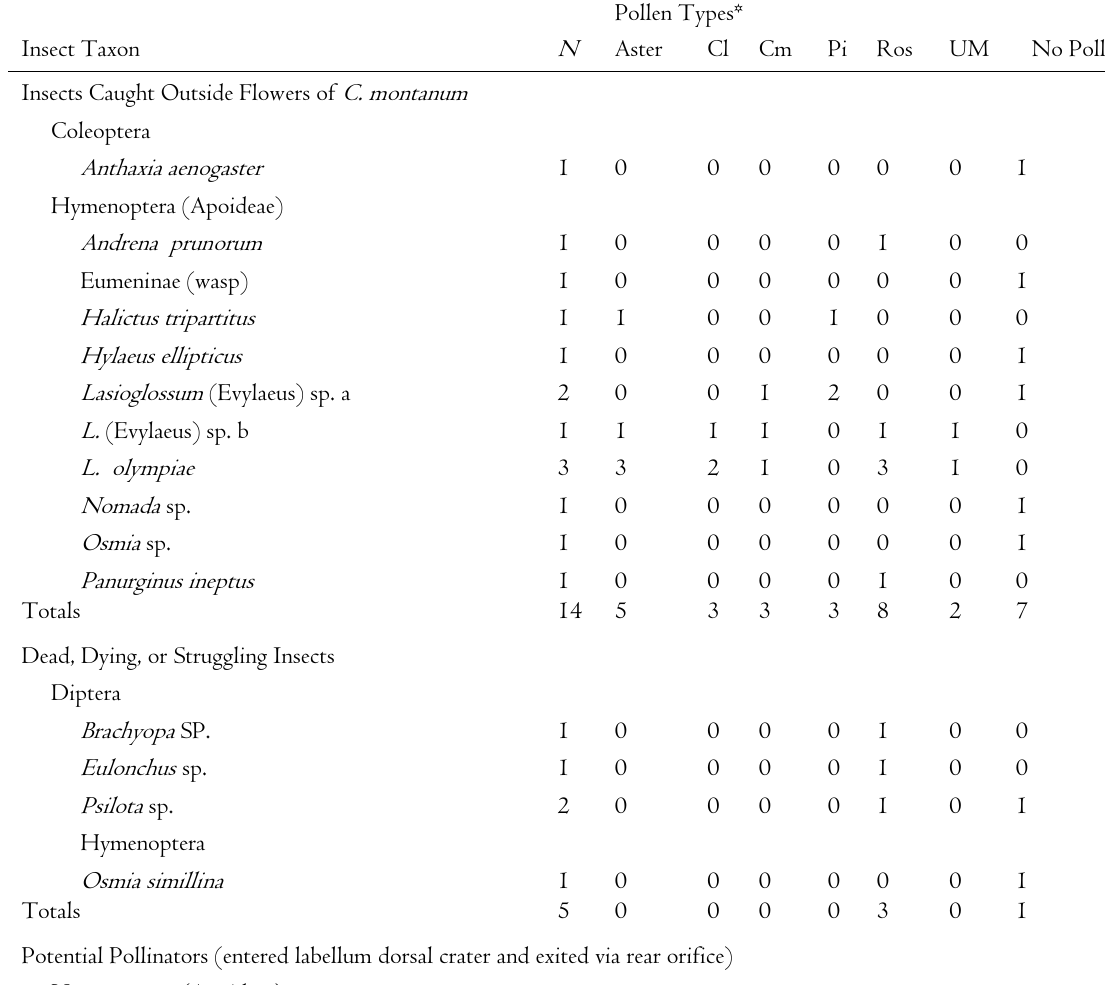
Table 3. Pollen load analyses of insects collected on or in Cypripedium montanum at the BMEO site in 2003.